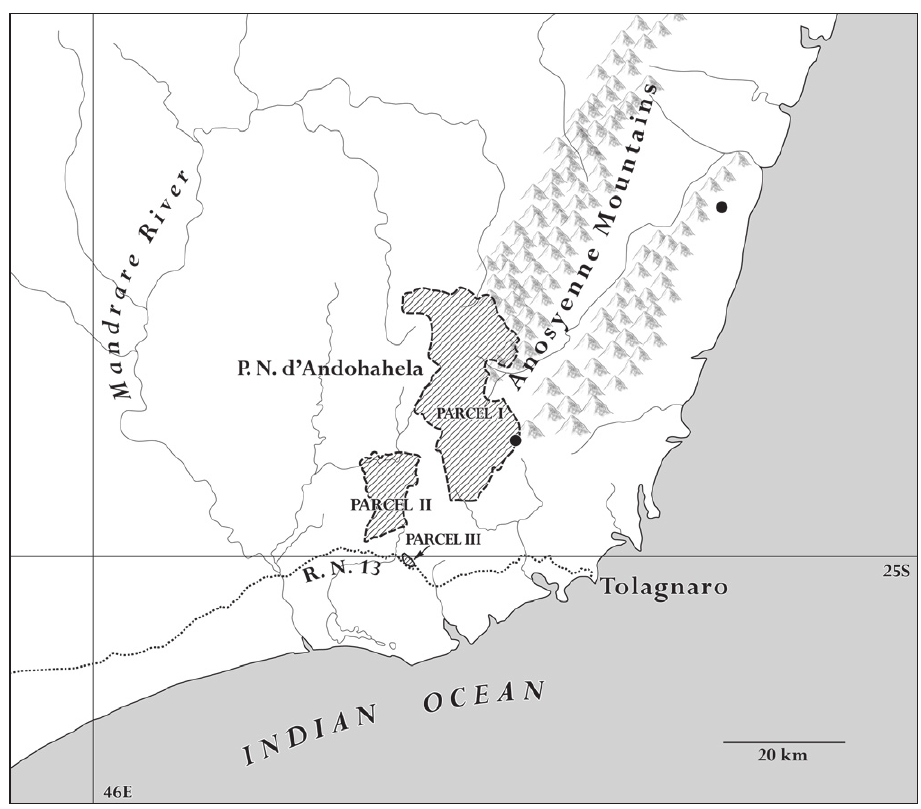
Figure 2. Map of extreme southeastern Madagascar showing where Nesogordonia tricarpellata Skema & Dorr has been collected and these two localities in relation to the three parcels that comprise the Parc National